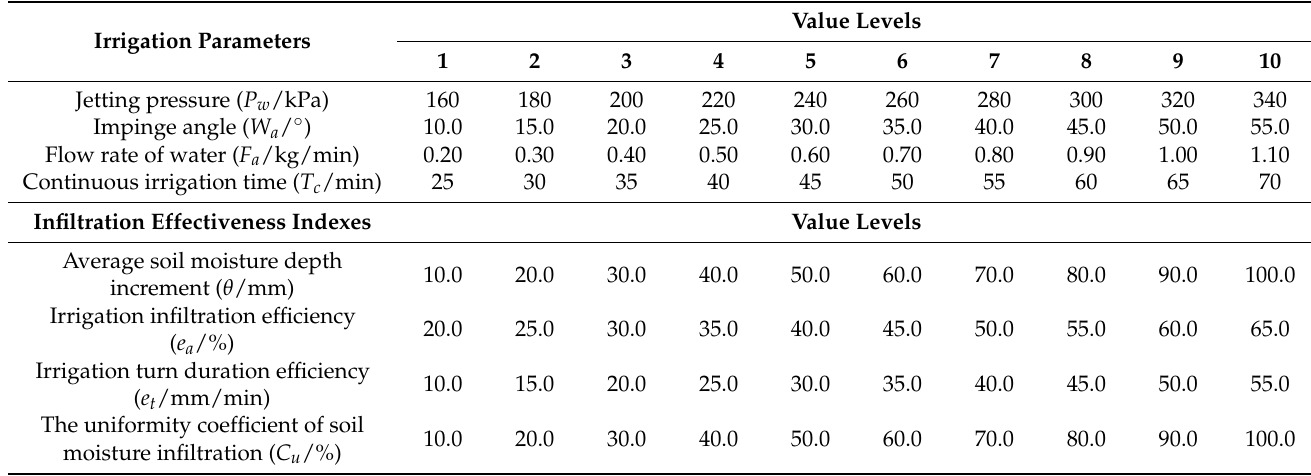
Figure 7. Profile comparisons between the predicted and actual measured droplet infiltration indexes at different soil depths. Table 2. The partitioned levels of irrigation parameters and infiltration effectiveness indexes, used as input and output variables of RSAE–ANFIS system for infiltration effectiveness